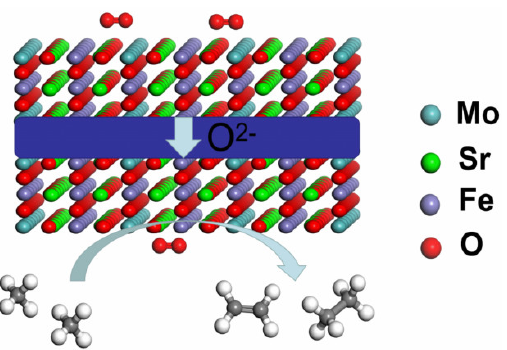
Figure 1. Electrochemical oxidation of CH 4 to chemicals. Anode electrode: 4CH 4 + 3O 2 − → C 2 H 4 + C 2 H 6 + 3H 2 O + 6e − . Cathode electrode: O 2 + 4e − → 2O 2 − .